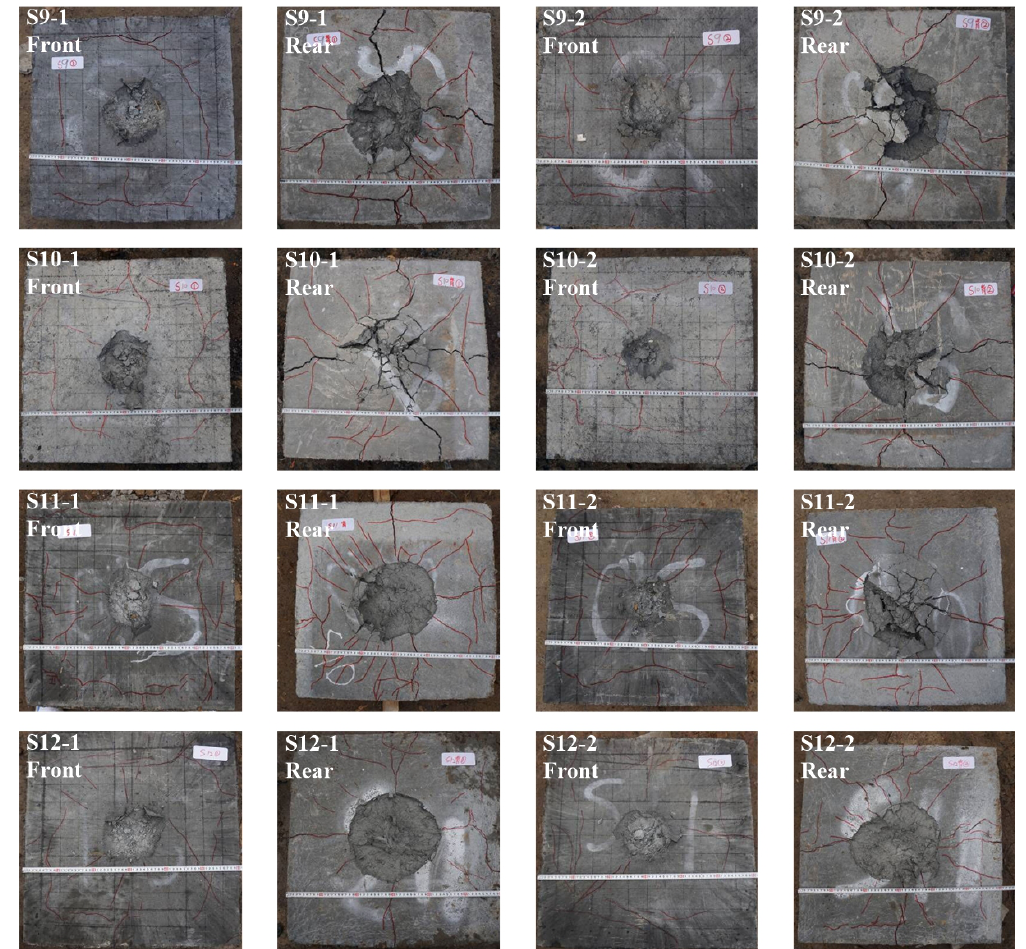
Figure 10. Damage mode of PVA-Steel HFRC